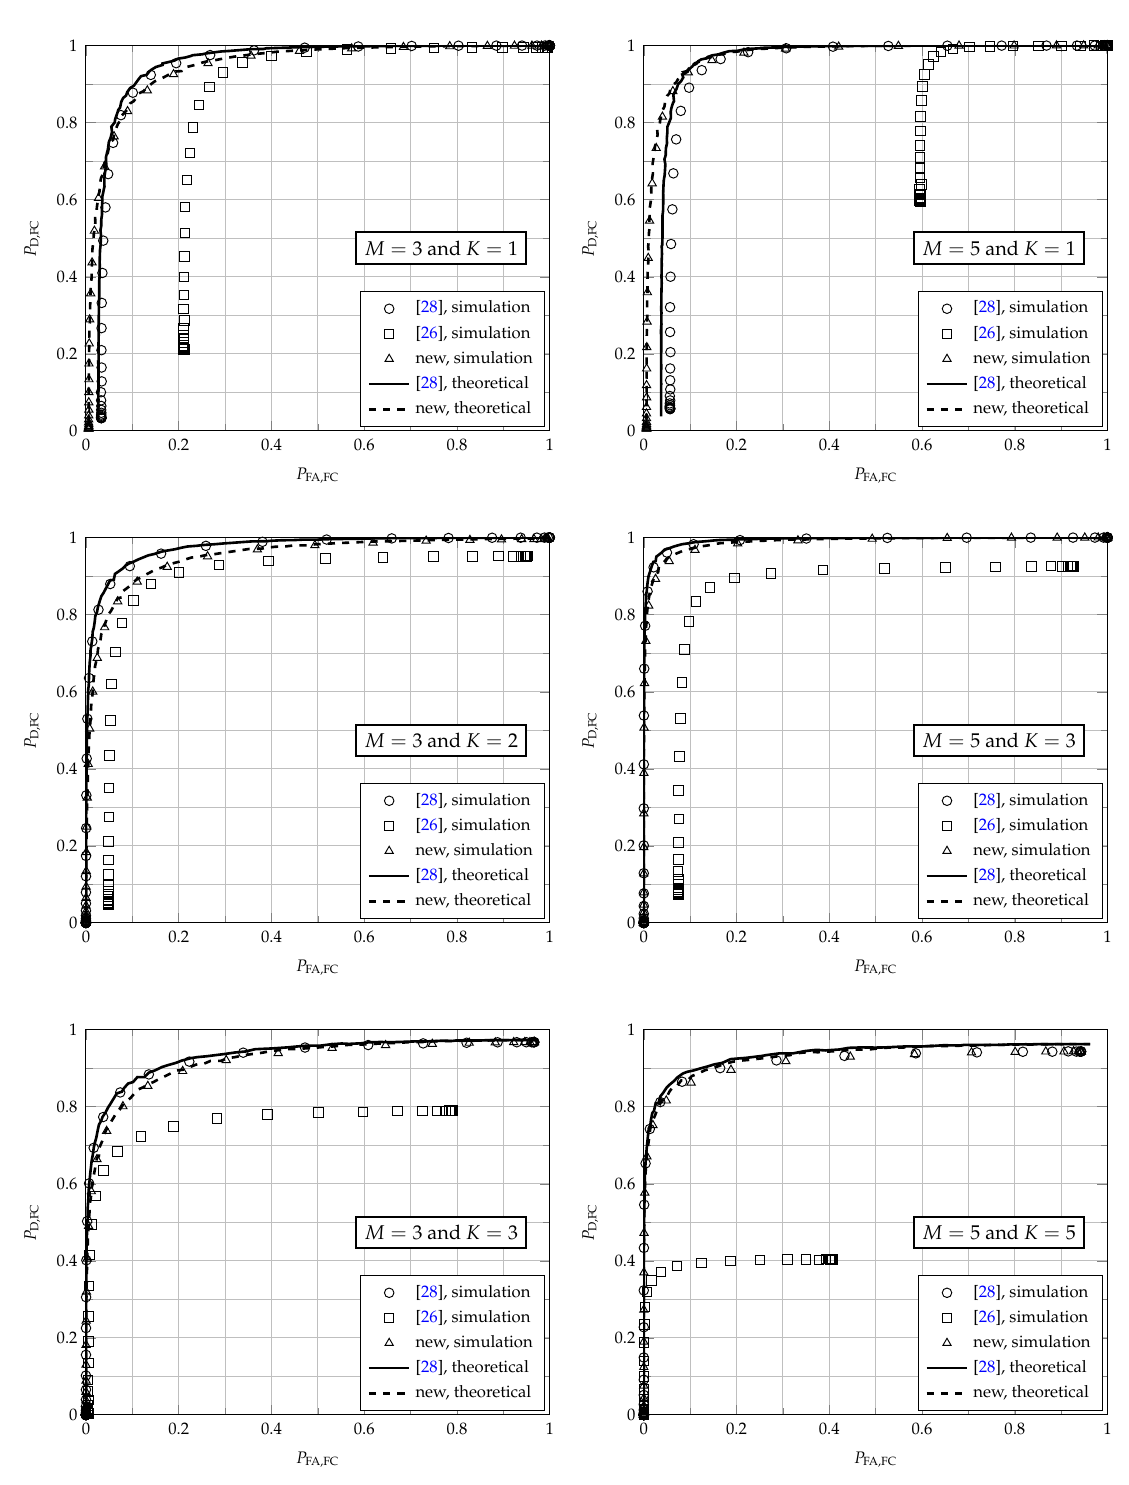
Figure 3. ROC curves at the fusion center for M = 3 (left), M = 5 (right), K = 1 (top), K = (cid:100) M /2 (cid:101) (middle) and K = M